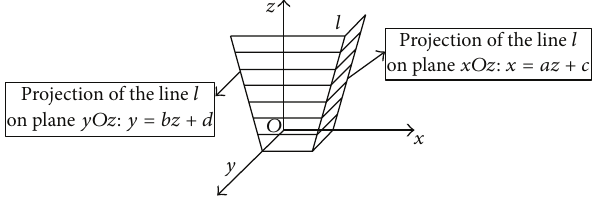
Figure 2: Illustration of the geometric meaning of expression